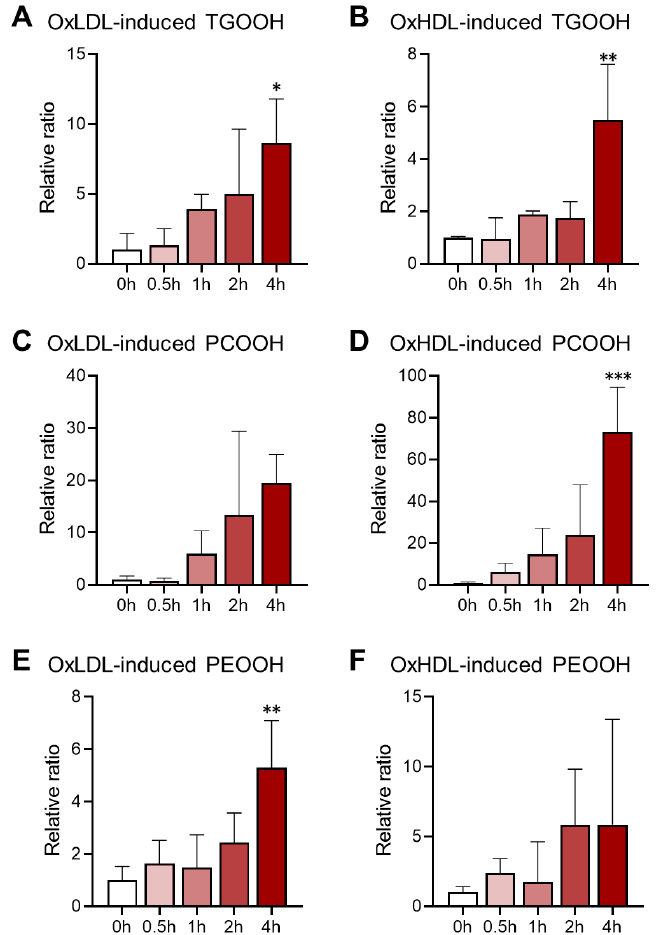
Figure 6. Accumulation of lipid hydroperoxides in LDs of oxidized lipoprotein-induced cells, including TGOOH ( A , B ), PCOOH ( C , D ), and PEOOH ( E , F ). * p < 0.05, ** p < 0.01, *** p < 0.001 vs. 0 h group, calculated by one-way ANOVA with Dunnett’s post hoc test.